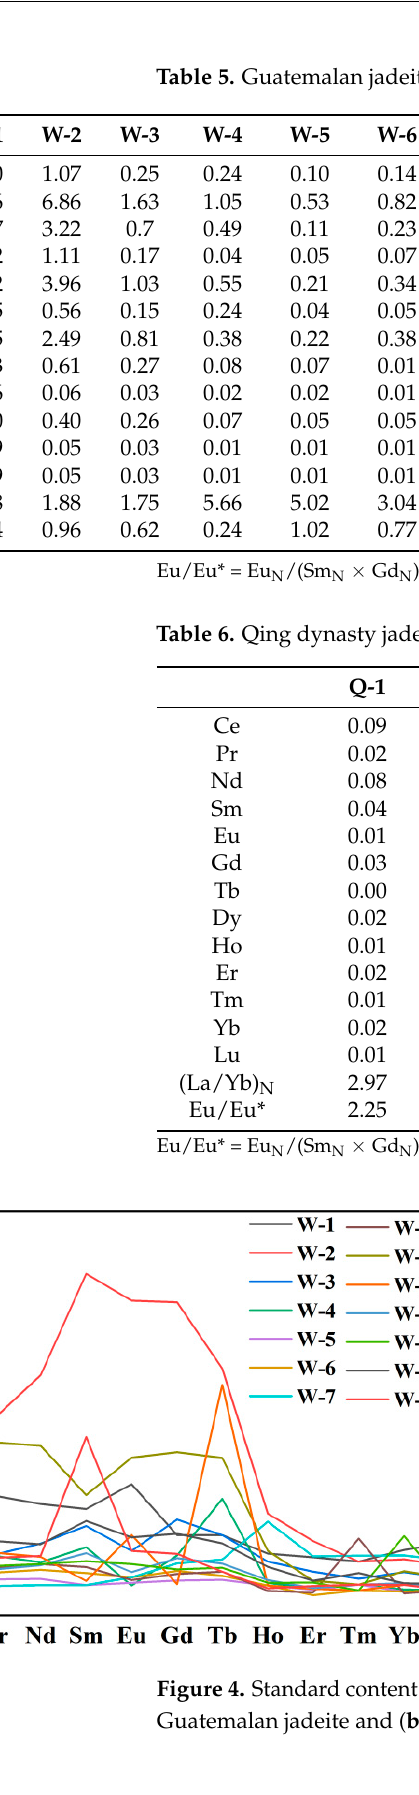
Table 5. Guatemalan jadeite rare earth elements (ppm).